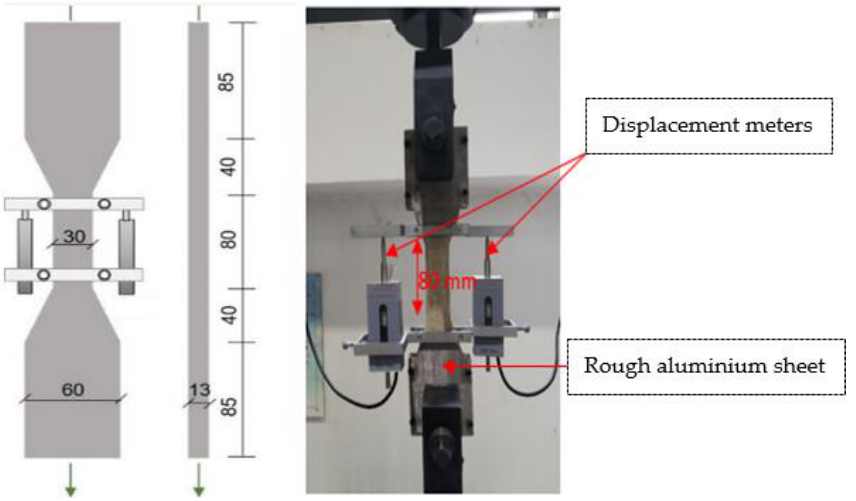
Figure 4. Experimental setup for the tension test (Unit: mm).